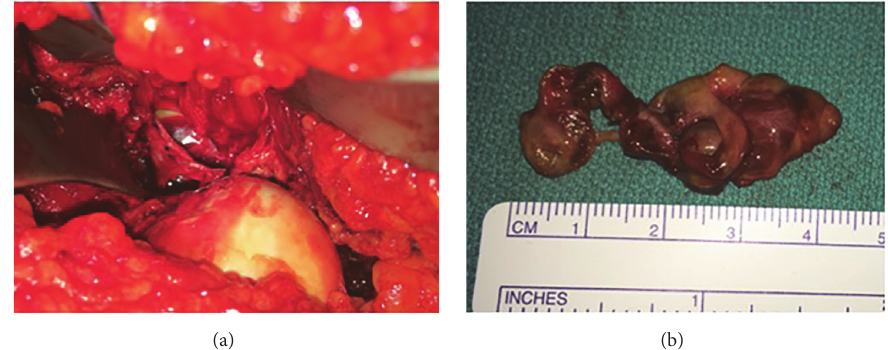
Figure 4: Intraoperative image of a surgical dislocation of the left hip in Case 2 , which allowed for adequate exposure to visualize and excise the mass (a). Gross pathology of the tumor from the same case is depicted (b), excised en bloc from the posterior-inferior aspect of the capsule and confirmed to be PVNS on formal pathological